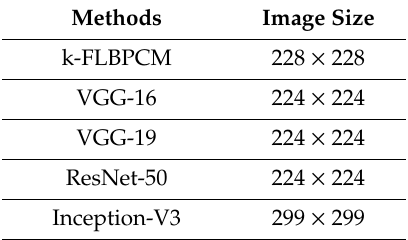
Table1. InputimagesizesusedfortheCNNandk-FLBPCMmodels,